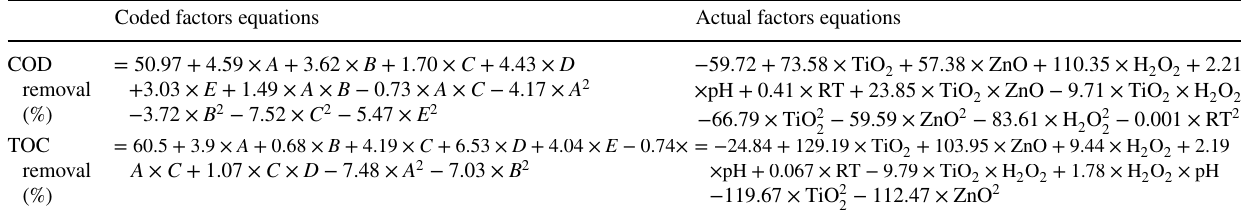
Table 5 Final ANOVA **regression model equations for COD and TOC responses in terms of actual and coded factors Coded factors equations